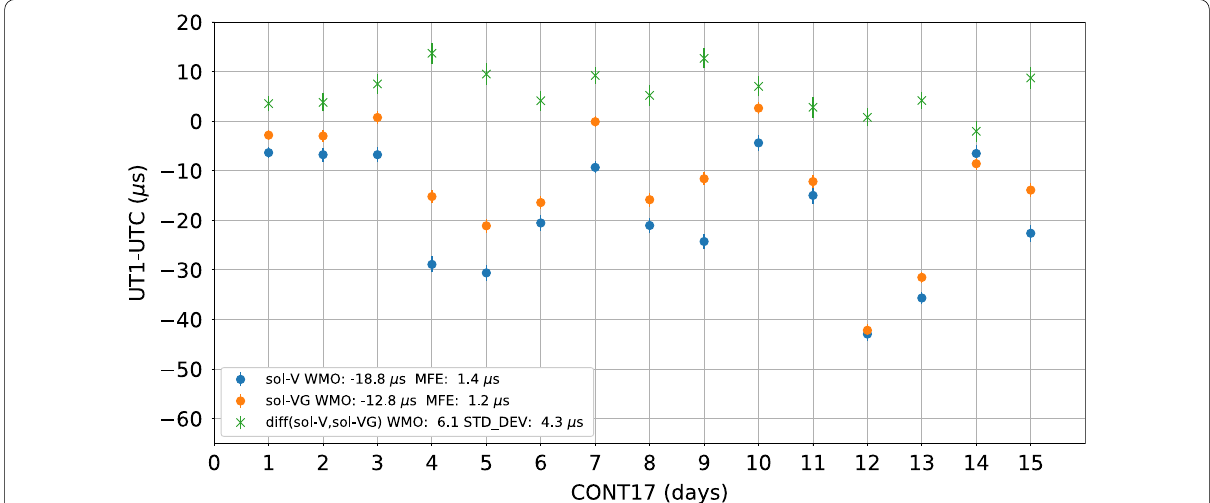
Fig. 11 UT1 estimates and differences between sol‑V and sol‑VG. Presented are weighted mean offset (WMO) and mean formal error (MFE)